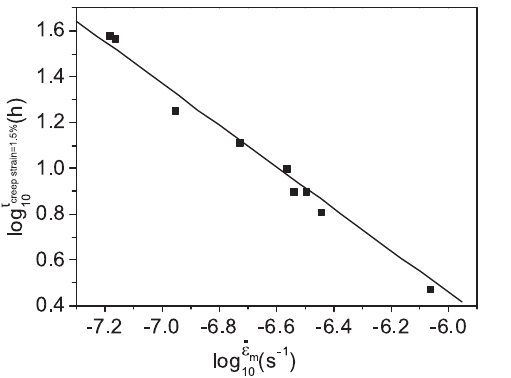
Fig. 4: Relationship between minimum creep rate and t creep strain=1.5% for the tests at 503, 533 and 563 K in the stress range 80–200